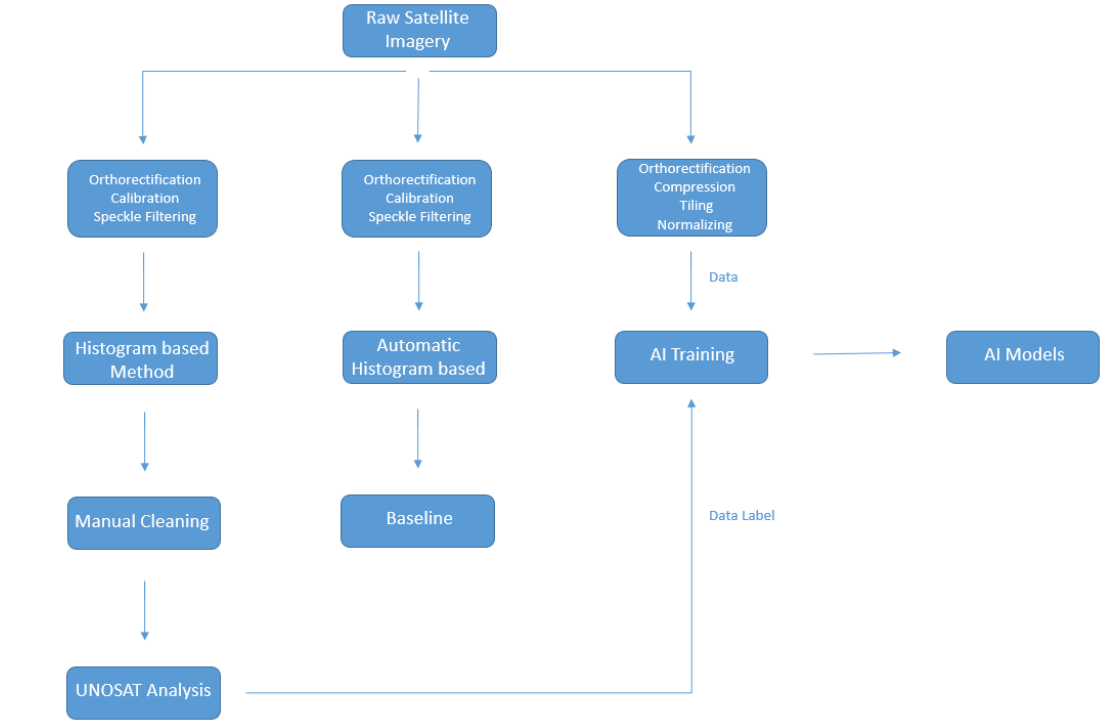
Figure 1. Overview of our general workflow. The histogram based method, the baseline and the neural network are computed using Sentinel-1 satellite imagery with different pre-processing steps as explained in Sections 2.2–2.4 respectively. The orthorectified imagery and the UNOSAT analysis are used to train the candidate algorithm as explain in Section 2.3. The neural network and baseline performances are then compared against the classically generated